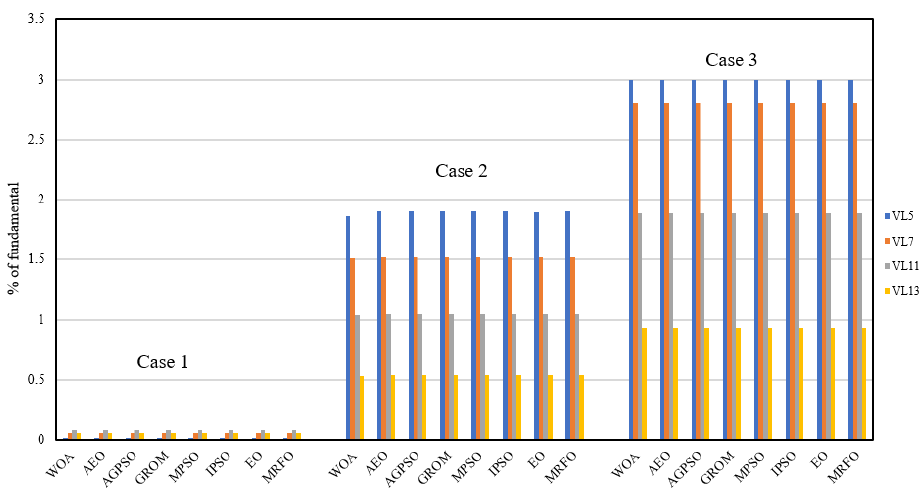
Figure 6. The individual voltage harmonics for configuration 2 of HAPF under the proposed three cases.